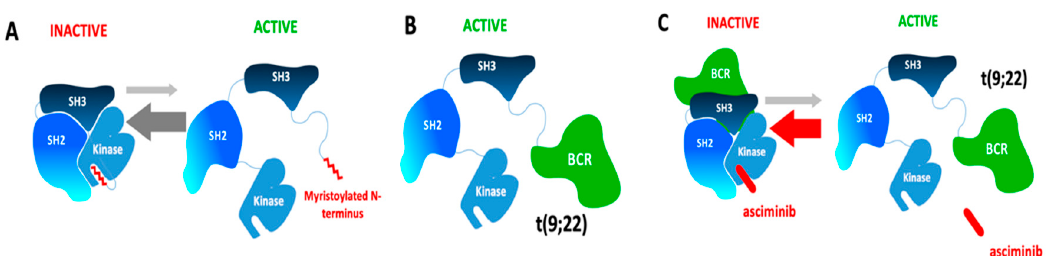
Figure 3. Binding of the Myristoyl Site of the BCR-ABL1 Protein by Asciminib. Autoinhibition of the ABL1 kinase occurs through engagement of the myristoyl-binding site by the myristoylated N -terminal-a negative regulatory motif that locks the ABL1 kinase in the inactive state ( A ). On fusion of ABL1 to BCR, the myristoylated N -terminal is lost and de ABL1 kinase is activated ( B ). By allosterically binding the myristoyl site, asciminib mimics myristate and restores inhibition of BCR-ABL1 kinase activity ( C ).